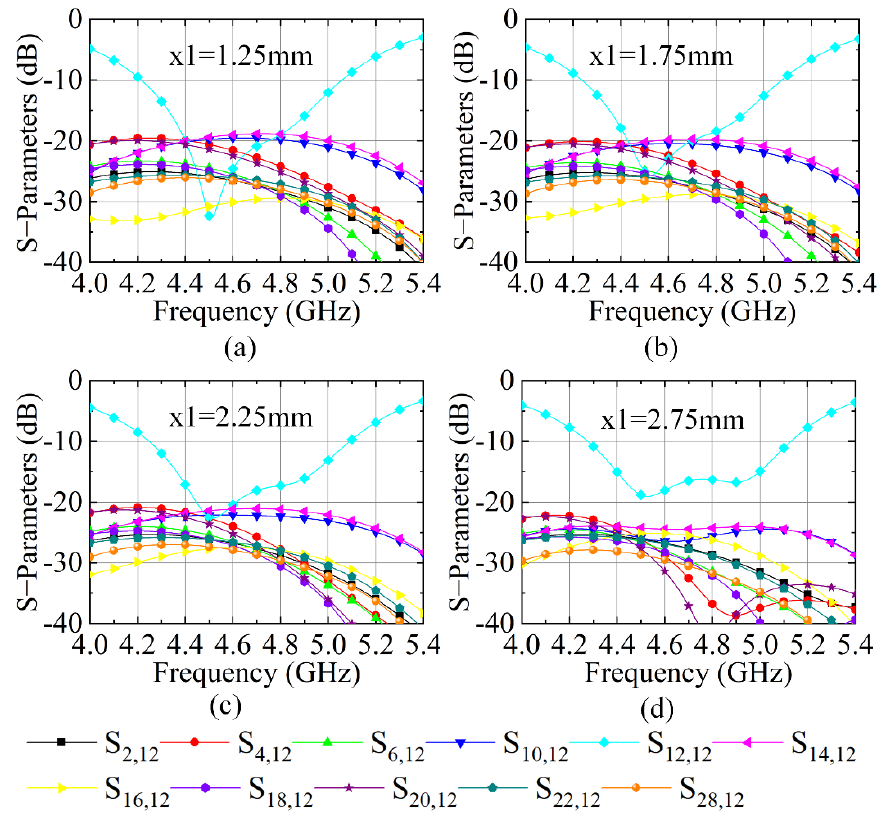
Figure 8. S-parameter of the antenna array loading with the proposed NRMS with different x1, ( a ) x1 = 1.25 mm, ( b ) x1 = 1.75 mm, ( c ) x1 = 2.25 mm, ( d ) x1 = 2.75 mm.